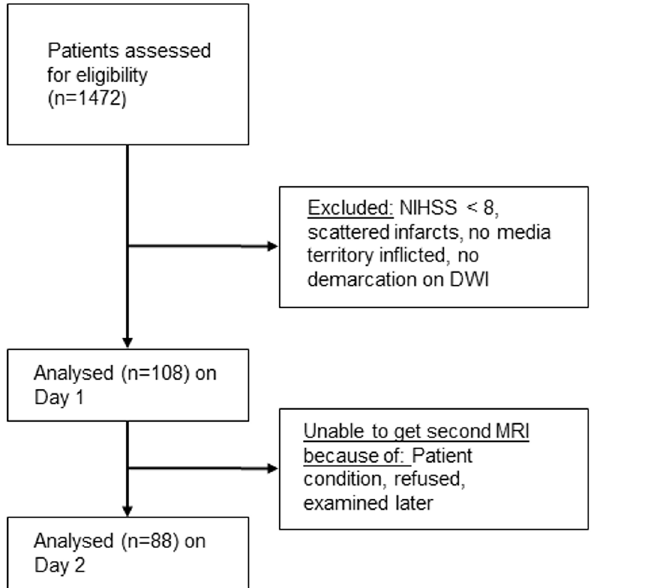
Fig 1. Flow diagram. Patient selection criteria for this study.